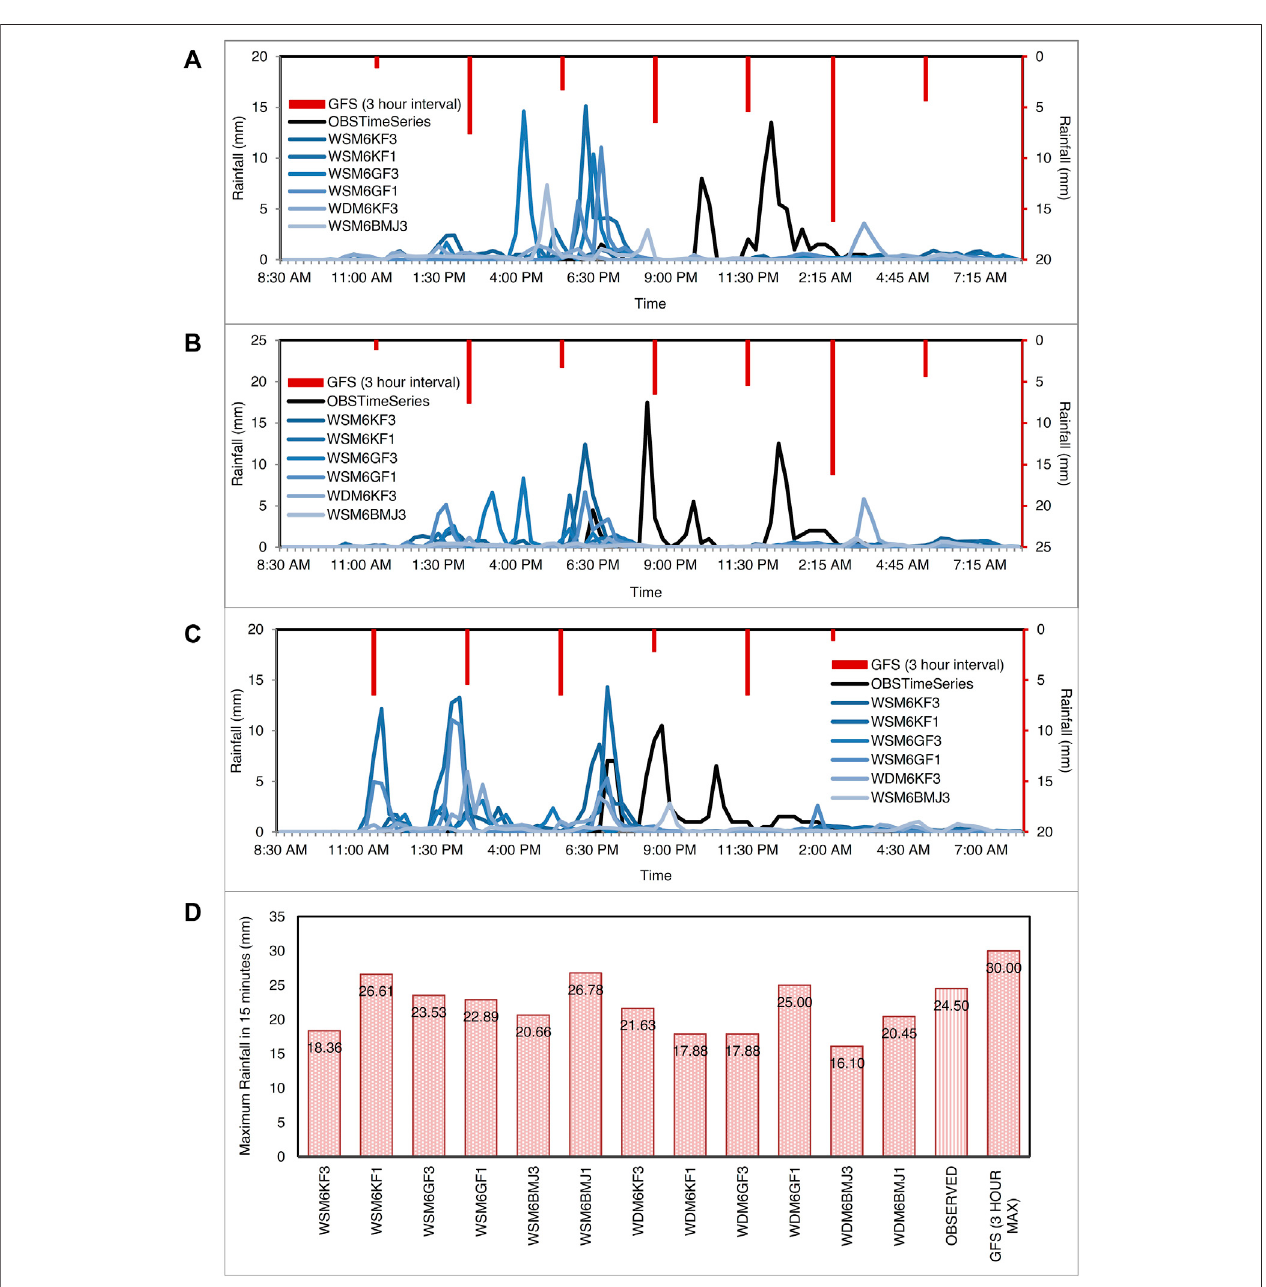
FIGURE4| Comparison ofrainfall time seriesfrom theselected forecastscenariosfor raingaugelocations. (A – C) ,Comparison ofrainfall timeseriesfrom theWRF forecasts, GFS forecasts and Observed rainfall for ARG locations in Koramangala-Chellaghatta valley (A) , Vrishabhavathi valley (B) , and Hebbal valley (C) . (D) , Comparisonof15-minmaximumrainfallfromeachmemberoftheensemblewiththe15-minmaximumvaluefromobservedARGnetwork.TheWRFensembleisableto capture the intensities of the event as compared to the GFS.